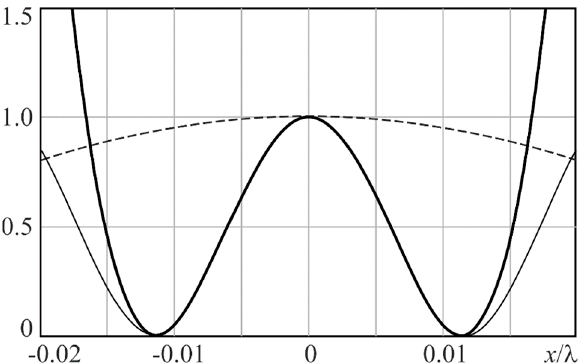
3 Figure 1. Superoscillating signal of Equation (1). To see the features of the field of Equation (1), it is necessary to zoom the region near x = 0 (see Figure 2, bold line). The function (Figure 2, dashed line) is also illustrated for comparison: